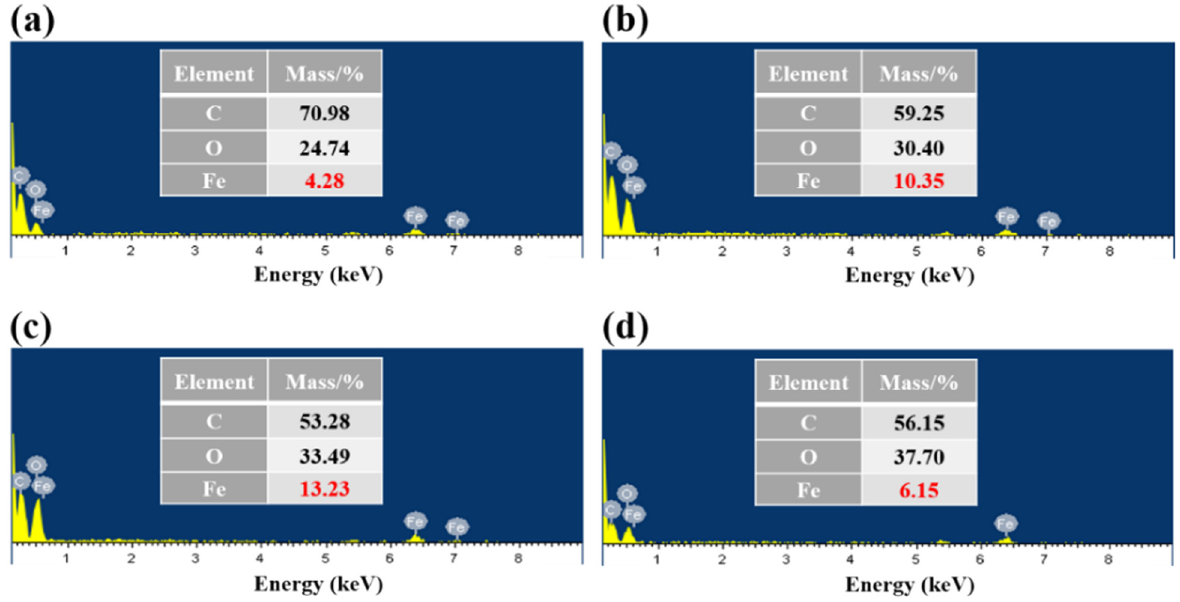
Figure 3: EDS spectra of SS - sputtered PET fi bers deposited under various sputtering conditions: ( a ) 5 Pa, 30 W, 15 min; ( b ) 5 Pa, 40 W, 15 min; ( c ) 5 Pa, 50 W, 15 min; and ( d ) 3 Pa, 50 W, 15